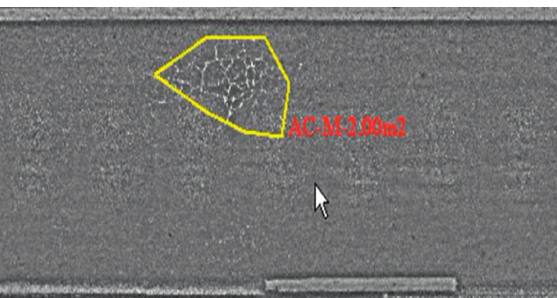
Figure 3: A sample of PCI calculation in Road Mapper software.